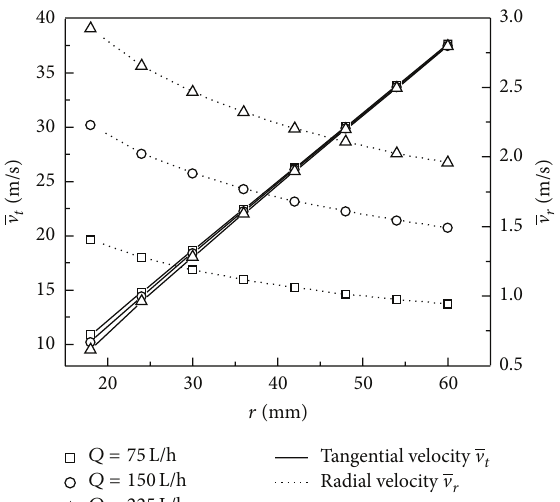
Figure 13: Variation in ligament number and droplet SMD with rotational speed.